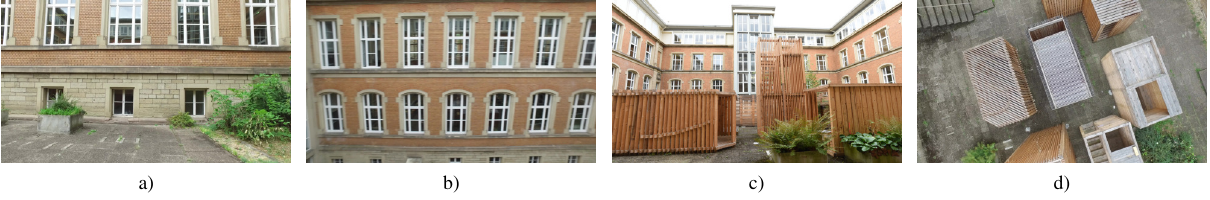
Figure 4. Image examples of the Atrium . a) Windows in the scene cause reflections, this is challenging for computer vision tasks, b) captured with high (angular) motion and therefore shows motion blur, c) shows ambiguous structures. d) is a test image of the low coverage sequence (Section 7.2) captured at high altitude. A similar perspective is not contained in the training data, the pose is ’far away’ from any training pose (position as well as orientation).